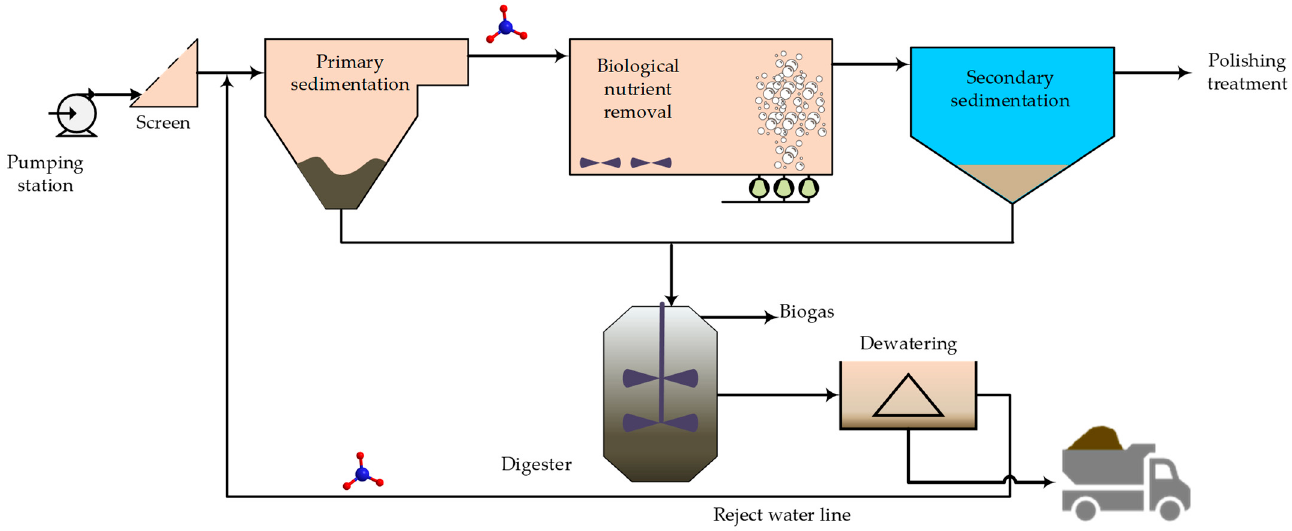
Figure 7. A simplified scheme of a typical wastewater treatment plant.